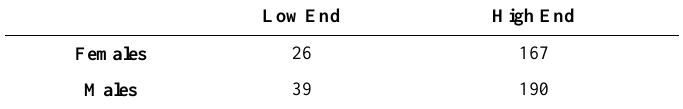
Table 1. Acceptable ranges for creatine kinase values in males and females.